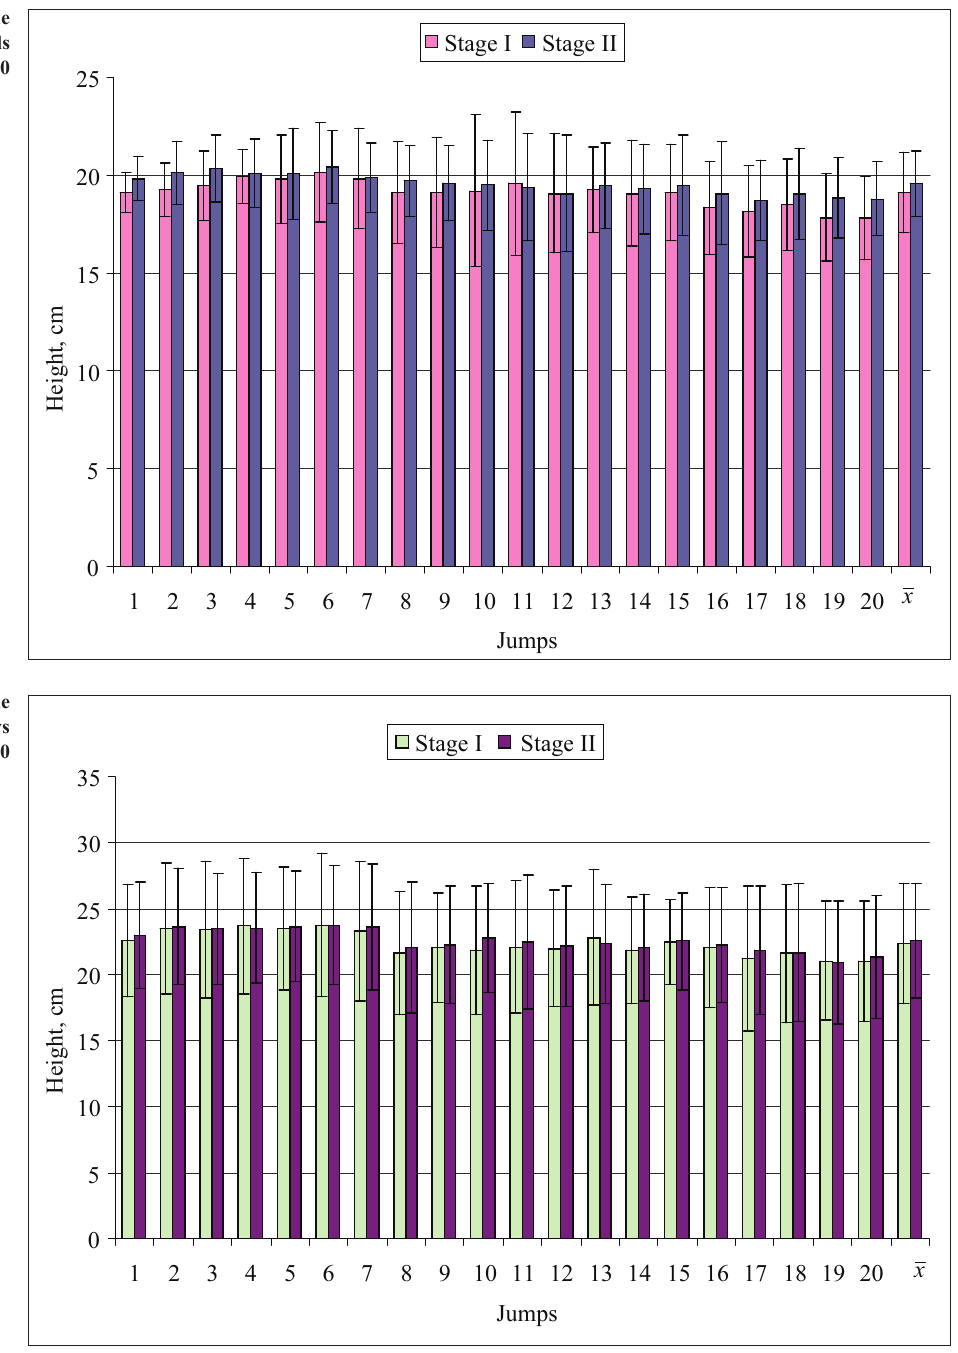
Figure 6. Changes in the height of jumps for boys performing a series of 20 jumps